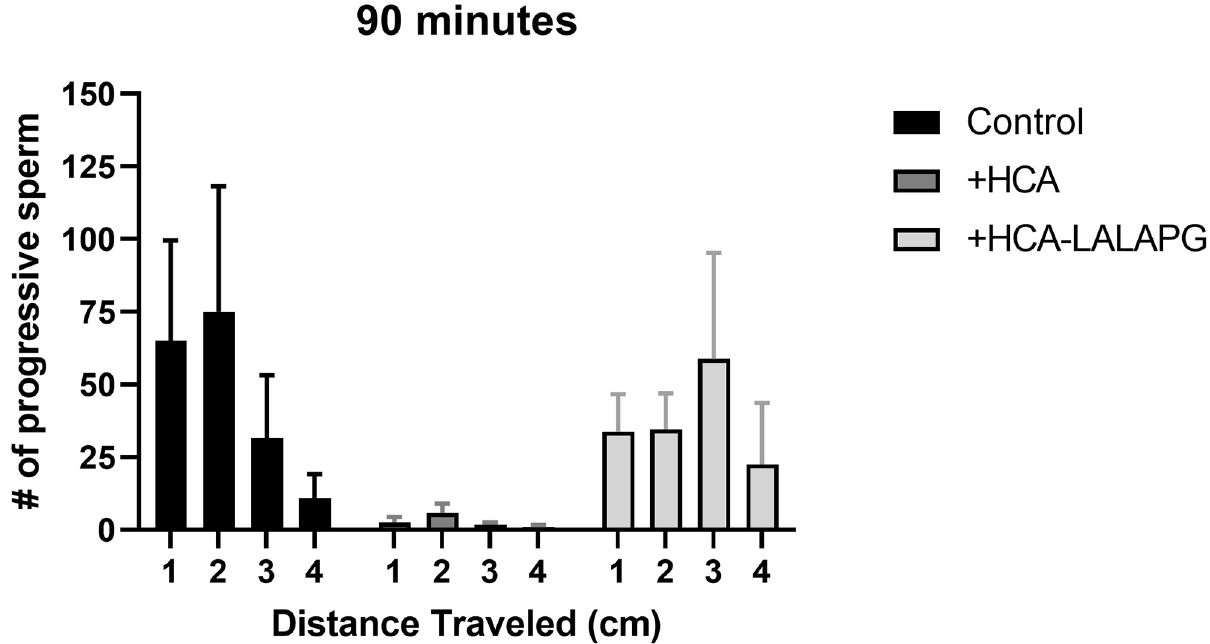
Fig 4. Cervical mucus penetration test with HCA and HCA-LALAPG. The number of progressively motile sperm at 90 minutes in ovulatory cervical mucus was significantly lower in the HCA treatment group than with HCA-LALAPG at all capillary tube depths (1–4 cm). Both antibodies were used at a concentration of 12.5 μ g/mL. Data are shown as mean ± SEM and is representative of four independent experiments, each with a different cervical mucus donor. Statistical analyses were conducted using a repeated measures ANOVA of log transformed data followed by a Tukey multiple comparisons test. Results were significant when p � 0.05. ( * = p � 0.05, ** = p � 0.01, *** = p � 0.001, **** = p � 0.0001).